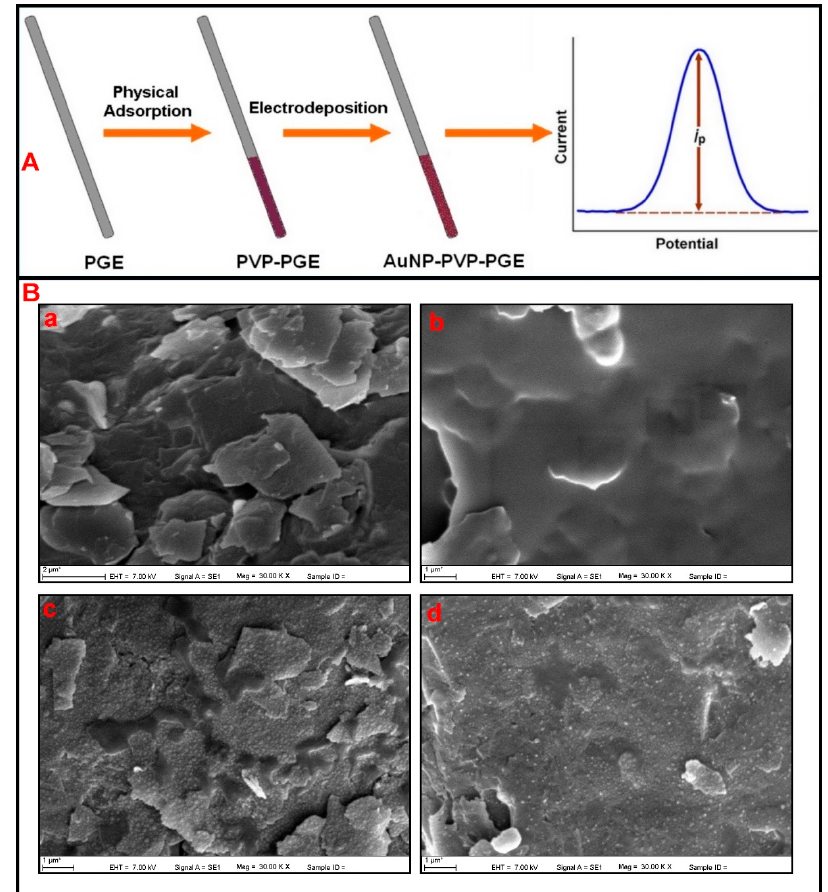
Figure 2. ( A ) Schematic presentation of the work; ( B ) scanning electron microscopy (SEM) images